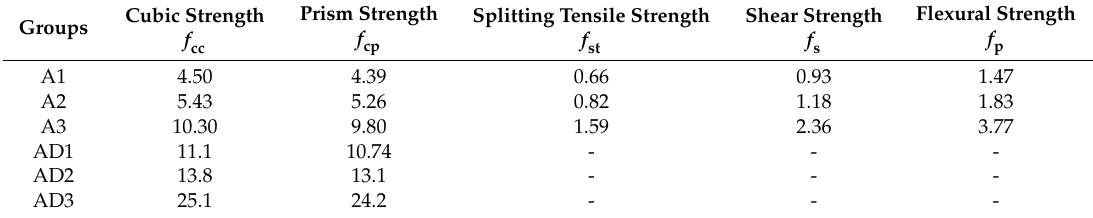
Figure 8. Failure types of the specimens. ( a ) Specimen of group A under cubic strength; ( b ) Specimen of group AD under cubic strength; ( c ) Splitting tensile failure for the group A specimen; ( d ) specimen of group A under prism strength; ( e ) Specimen of group AD under prism strength; ( f ) Specimen with shear failure. Table 5. Compressive, shear, and splitting tensile tests results.